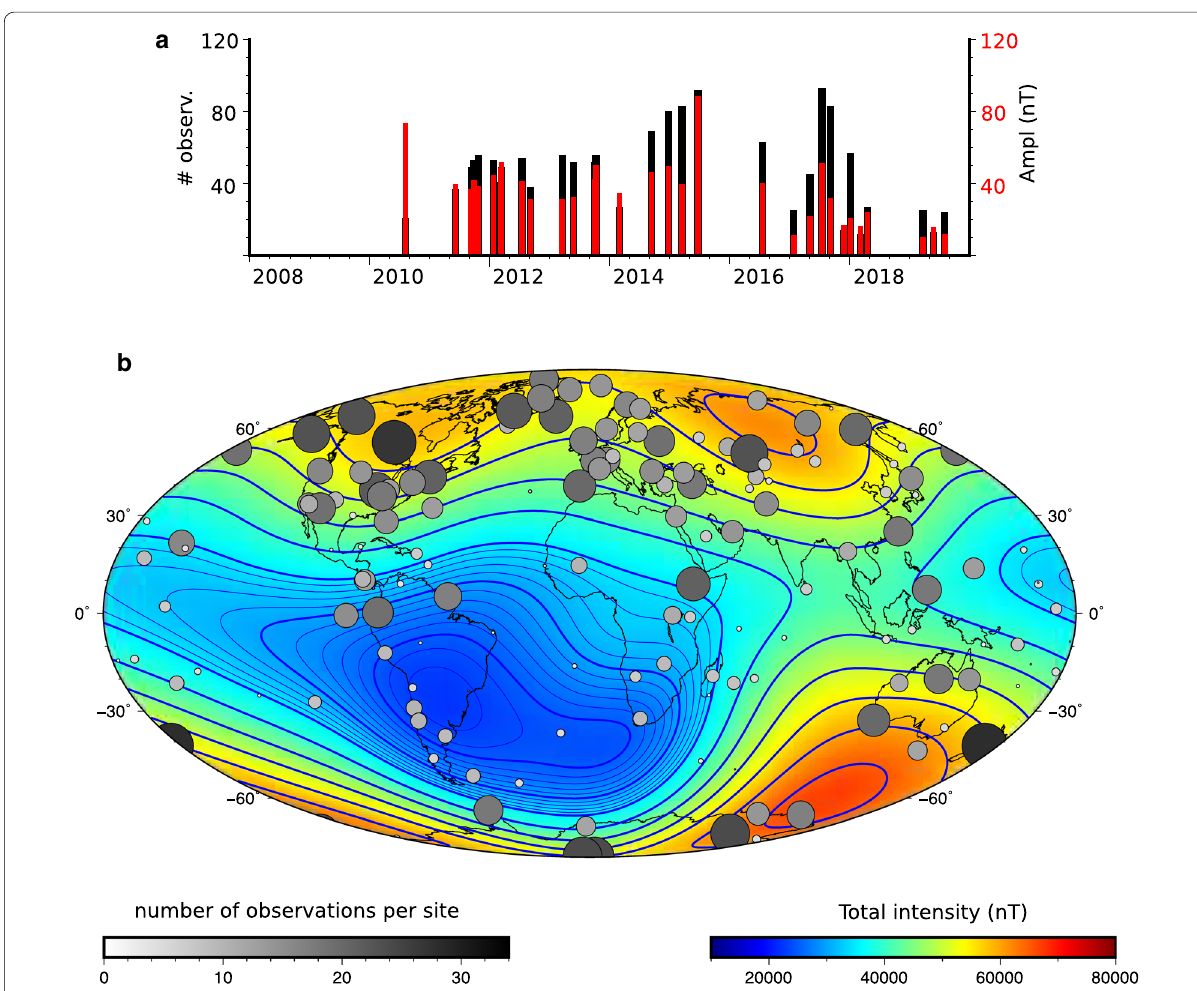
Fig. 3 Magnetic amplitude of the SSC events vs. seismic observations. a Mean amplitude of the significant SSC events during the 24th solar cycle (red bars) compared with the number of observations of each event in the broad-band stations (black bars). b Total magnetic intensity (NCEI Geomagnetic Modeling Team and British Geological Survey 2019) for year 2018 compared to the number of SSC observations for each investigated broad-band seismic station. F isolines are shown every 1000 nT below 35,000 nT and every 5000 nT above this value to better constrain the SAA anomaly. The size and gray saturation of the circles represent the number of observations at each seismic site, with small white dots representing seismic sites without